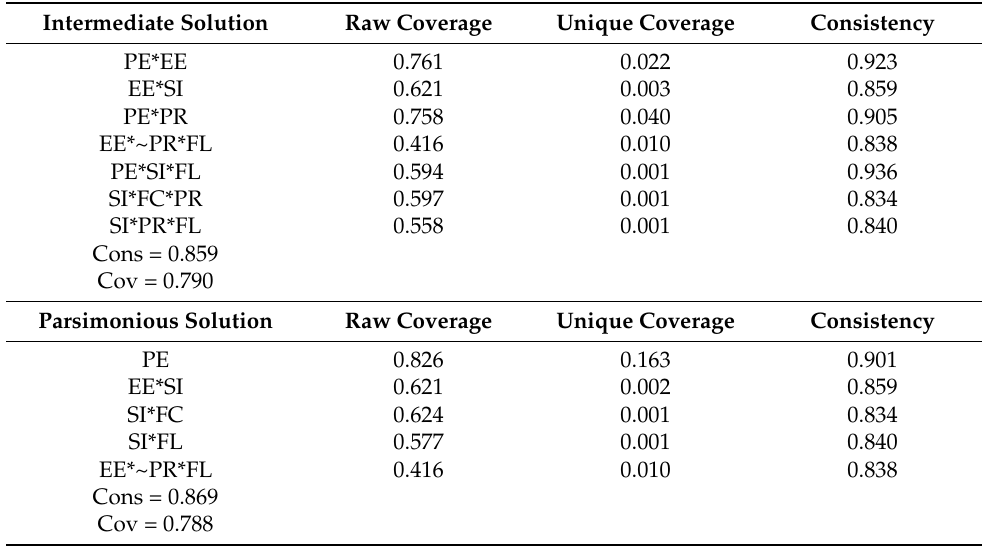
Table 4. QCA-IS and QCA-PS for the model IU = f(PE, EE, SI, FC, PR,